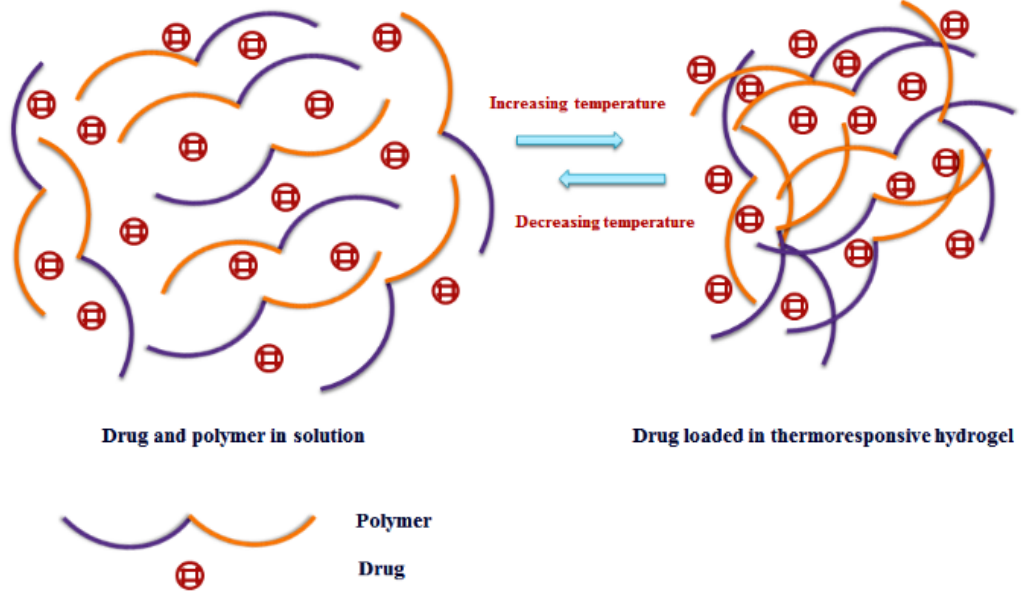
Figure 1. Thermoresponsive hydrogel formation using temperature as a trigger.